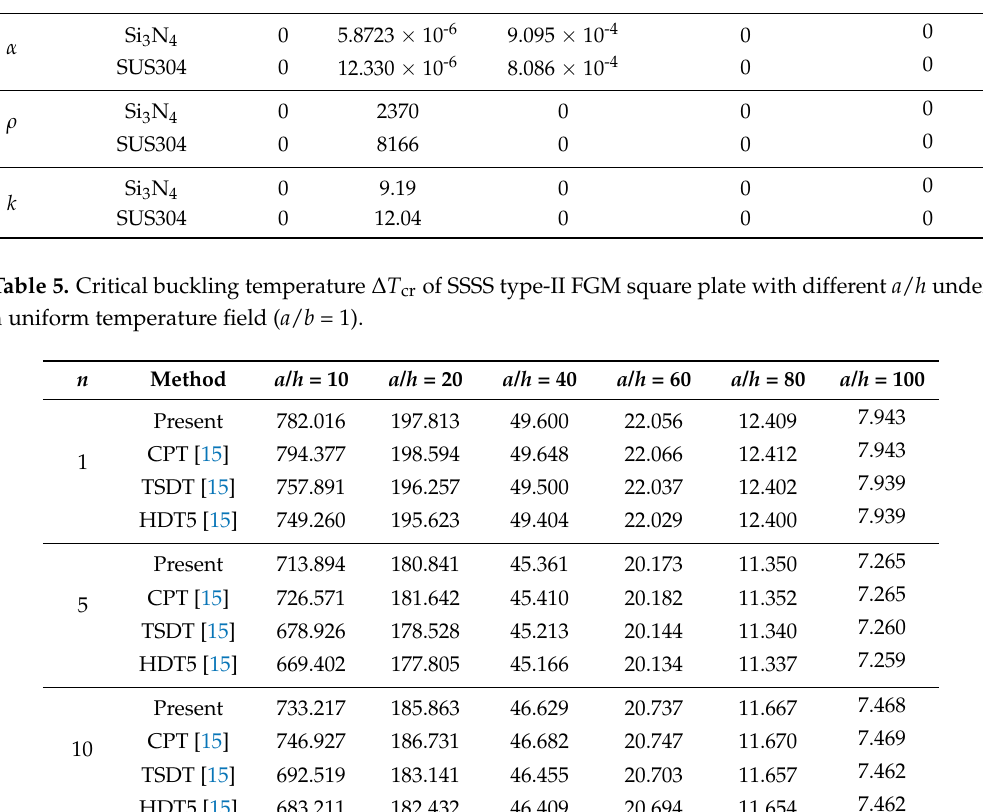
Table 6. Critical buckling temperature Δ T cr of SSSS type ‐ II FGM plate with different a / b under a uniform temperature field ( a / h = 100).